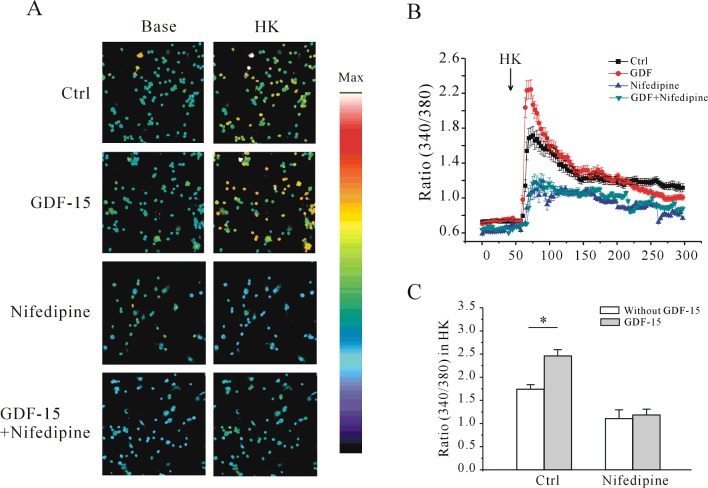
Effect of nifedipine on the increase in [Ca2+]i elicited by high K+ in CGNs with or without GDF-15 treatment(A) Ca2+ imaging before and after depolarization by application of a 27-mM K+ solution in GDF-15-treated CGNs in the presence or absence of nifedipine. Scale bar, 50 μm. (B) Changes in [Ca2+]i upon application of a depolarizing stimulus, as measured by quantification of fluorescence excitation ratios. Each arrow represents a 30-s perfusion with a depolarizing 27-mM K+ solution. (C) Statistical analysis of [Ca2+]i in control and GDF-15-treated CGNs in the presence or absence of nifedipine. Results are means±S.E.M. *P<0.05 for the two groups connected with a straight line. Ctrl, control.